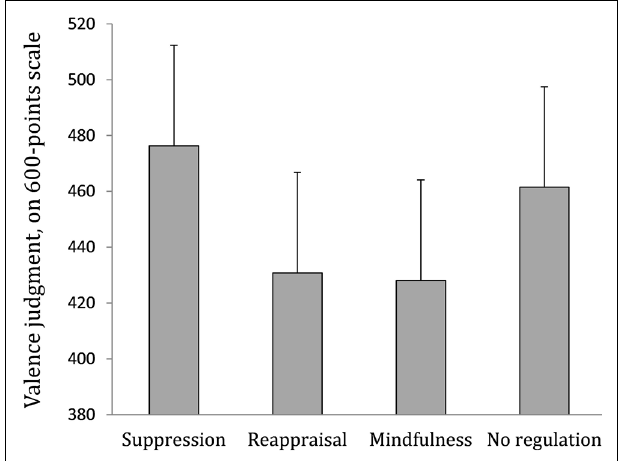
FIGURE 1 |Valence ratings depending on the regulation strategy condition. A higher score represents a more positive valence judgment (300 = neutral judgment). Error bars indicate standard errors of